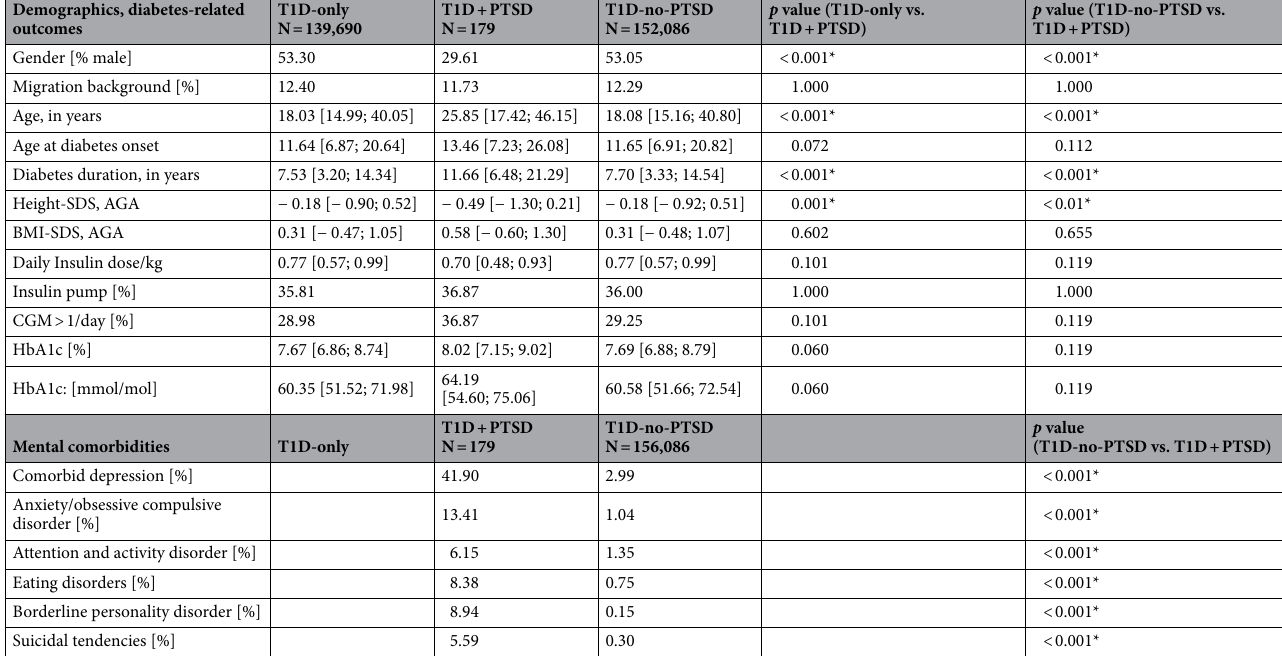
Table 1. Baseline characteristics of patients with T1D in all groups. All data are presented in median [25% quantile; 75% quantile] or percentage [%]. T1D = type 1 diabetes; PTSD = posttraumatic stress disorder ; T1D- only = patients with T1D without comorbid mental disorder; T1D + PTSD = patients with T1D and PTSD, with or without other mental comorbidities; T1D-no-PTSD = patients with or without other mental comorbidities, no PTSD; BMI = body-mass index; SDS = standard deviation score; AGA = Arbeitsgemeinschaft Adipositas im Kindes- und Jugendalter; CGM = continuous glucose monitoring; HbA1c = Hemoglobin A1c. * significant (p < 0.05).